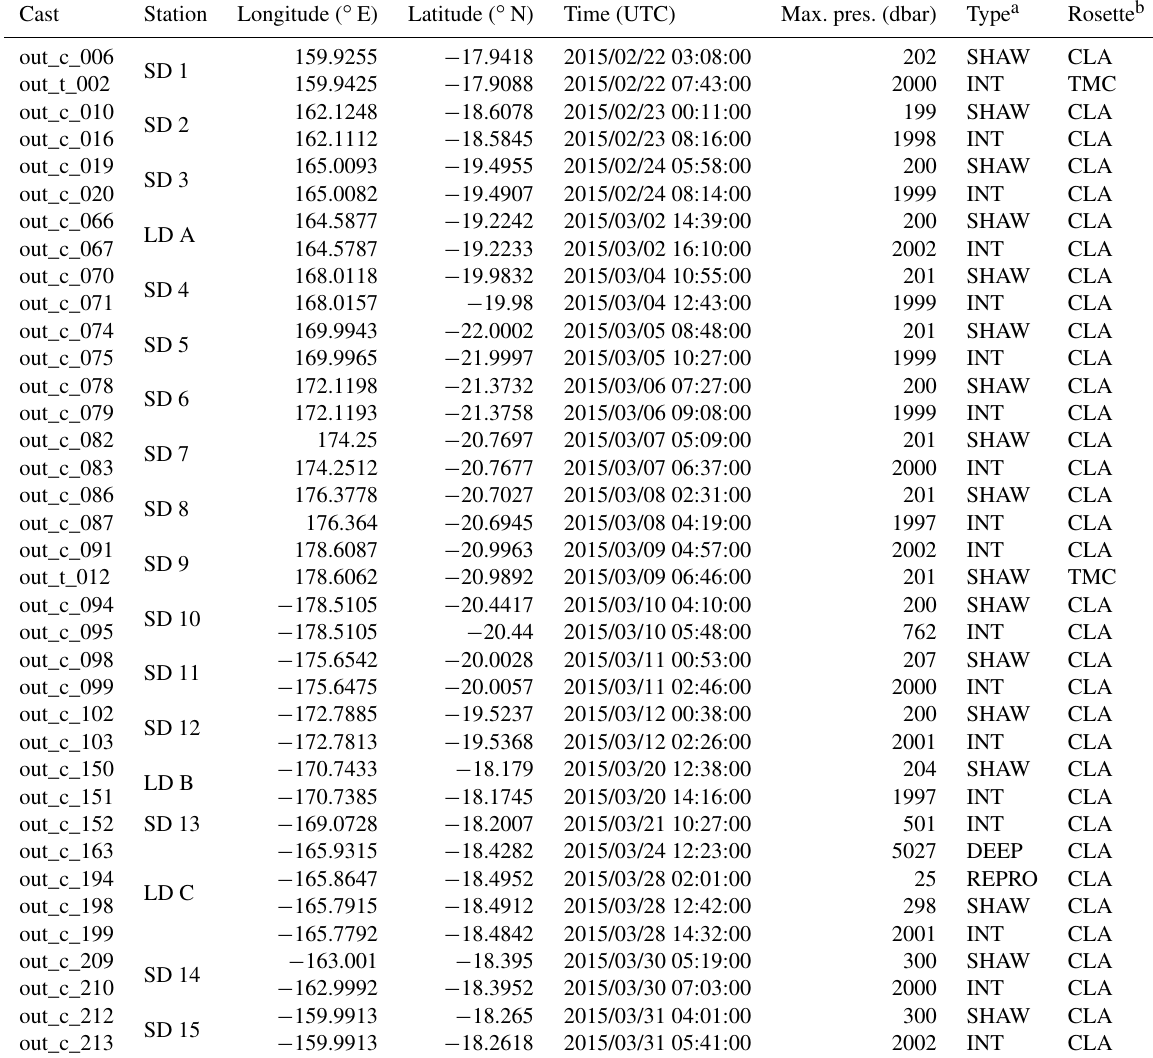
Table 1. General description of the casts sampled for carbonate chemistry parameters during the OUTPACE